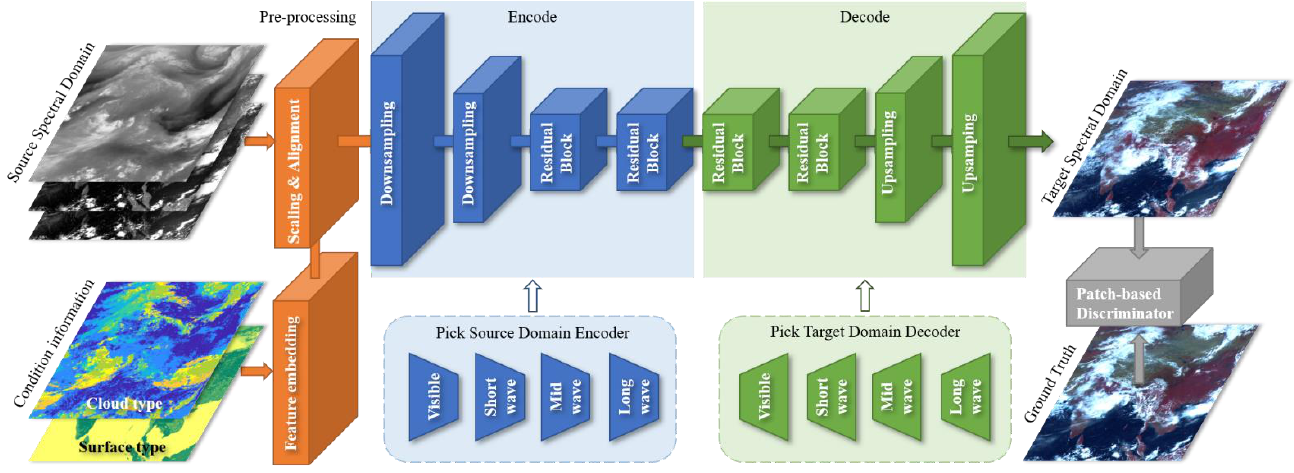
Figure 1. The framework of SDTGAN.